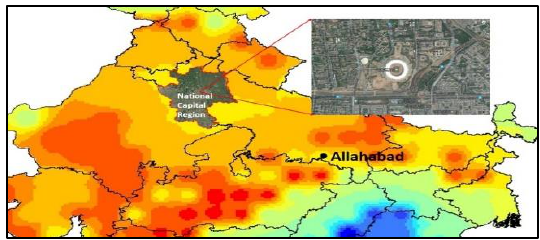
Figure 16 . Consecutive hot spots apparent near city centres such as National Capital Region (NCR) and Allahabad these, possibly as a consequence of transformation to new settlements. Three-dimensional analysis of the hot and cold spot showed majority of the hot spots are present in the northern part of India comprising the majority of the wheat growing regions of India (Figure 17). Large part of the eastern UP, western Bihar, Rajasthan and Gujarat are showing hotspots only during the recent few years. On the other hand regions of Maharashtra, Karnataka and Chhattisgarh are showing cold spots.